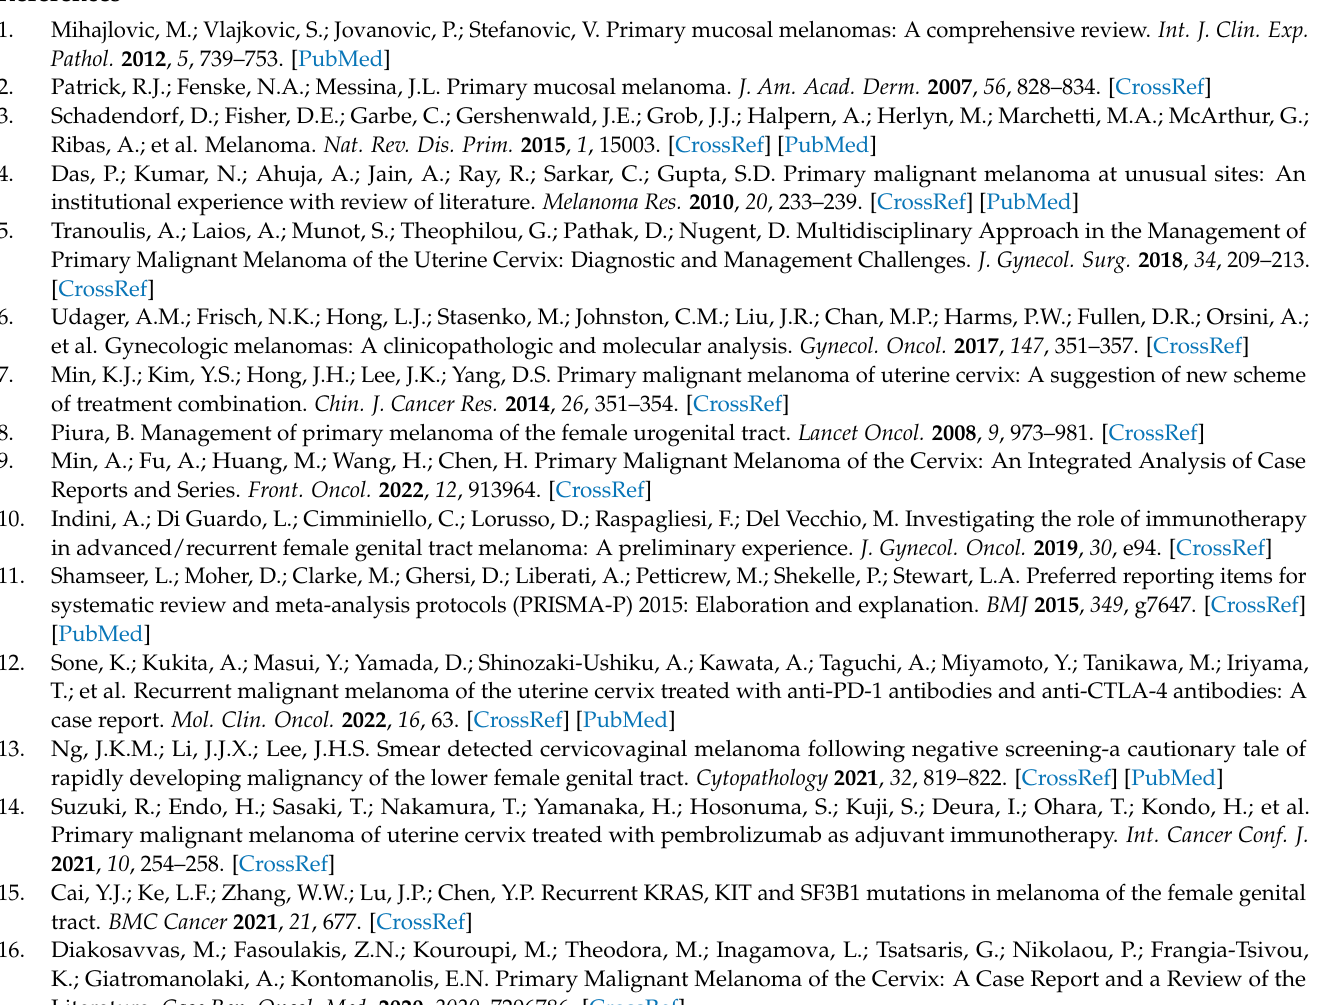
Table S2: Characteristics of the included studies; Table S3: Staging and therapeutic management of included patients; Table S4: Quality assessment of the included